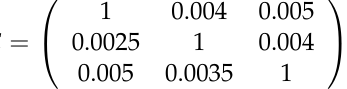
Figure 7. Evolution of x 1 ( k ), x 2 ( k ) and x 3 ( k ) for constant parameters in Example 4. Species 1 dominates the other two and harvesting quota and consumption are included.